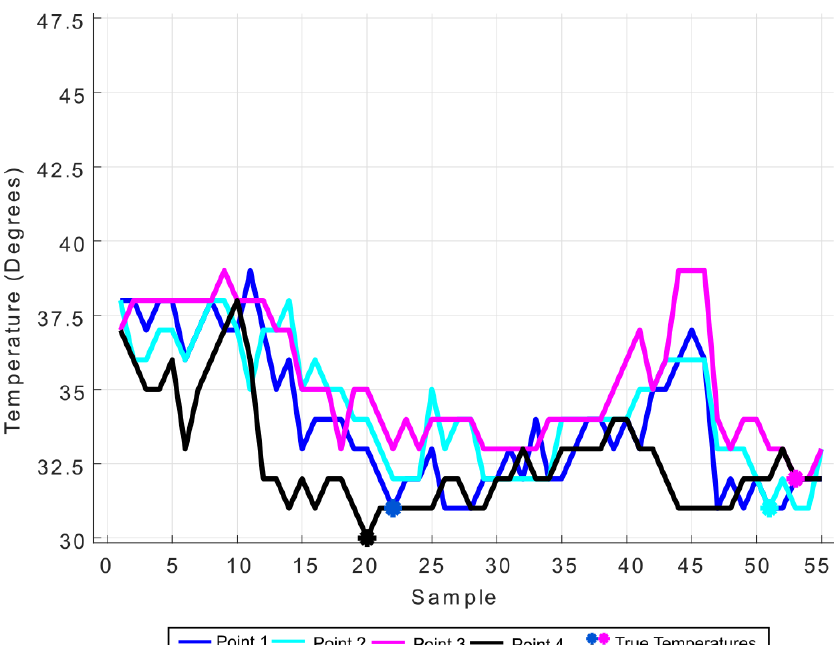
Figure 13. Temperature variation for each point along the test, with minimum temperature taken as real